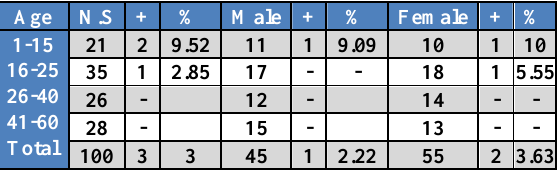
Figure, 1: Mucoid light dark brown fungal colonies on Sunflower seeds agar. Table, 1: Prevalence of fungal isolates according to age and